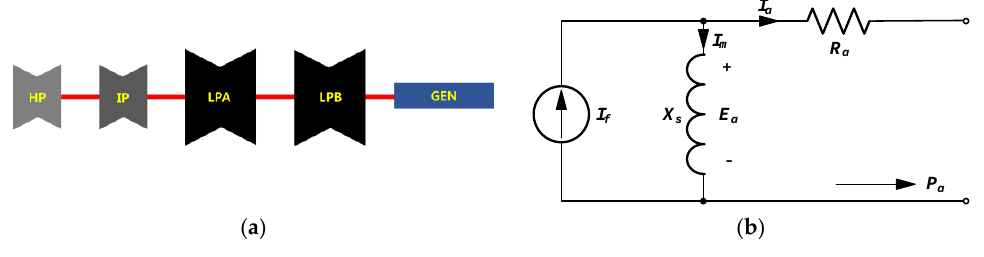
Figure 3. Turbine-generator segments and electrical equivalent circuit: ( a ) Segments of the turbine-generator; ( b ) Current-source equivalent circuit for the synchronous generator.